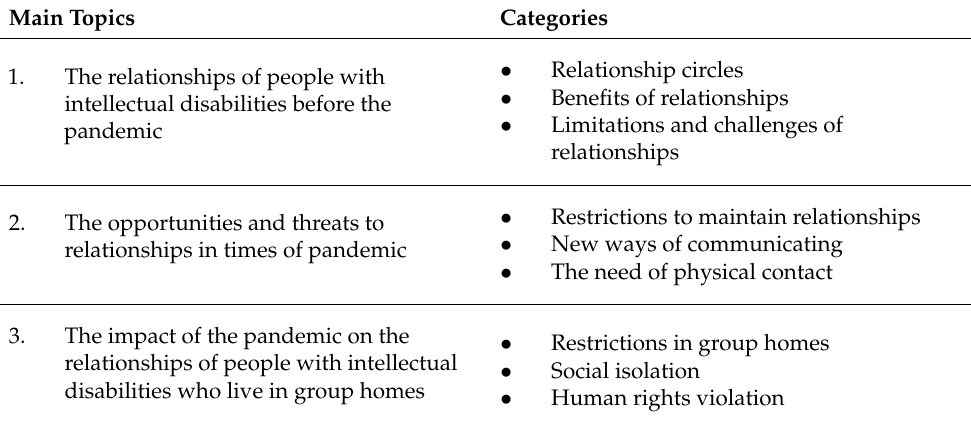
Table 1. Main topics and categories derived from the analysis of the interviews and focus